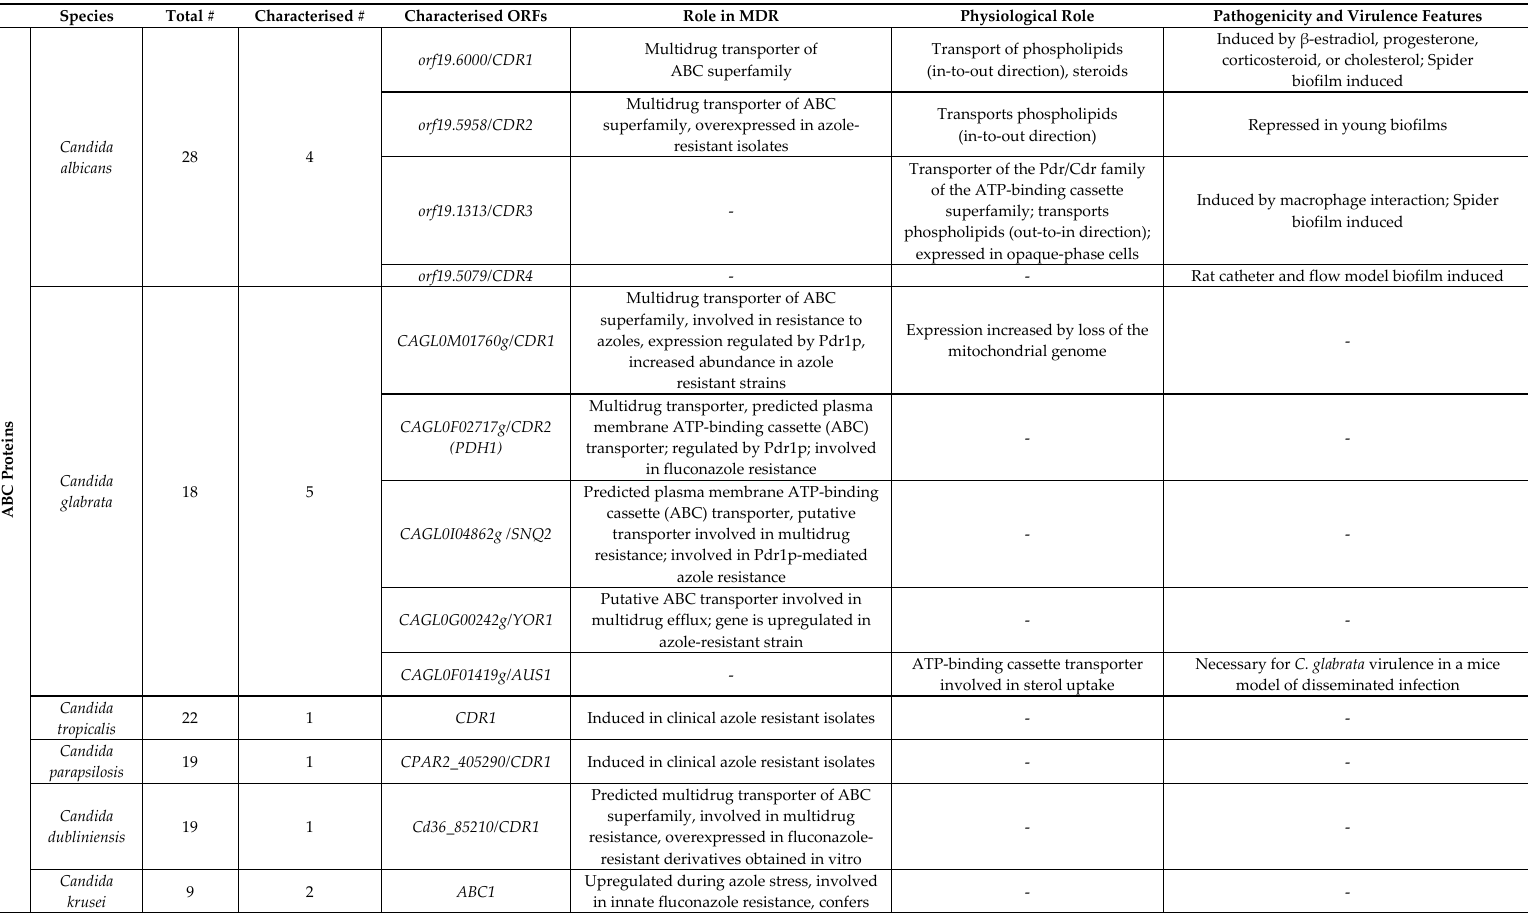
Table 1. ATP-binding cassette (ABC) transporters of Candida , Aspergillus , and Cryptococcus species focusing their roles in multidrug resistance (MDR) and physiological functions, as well as their pathogenicity and virulence features.